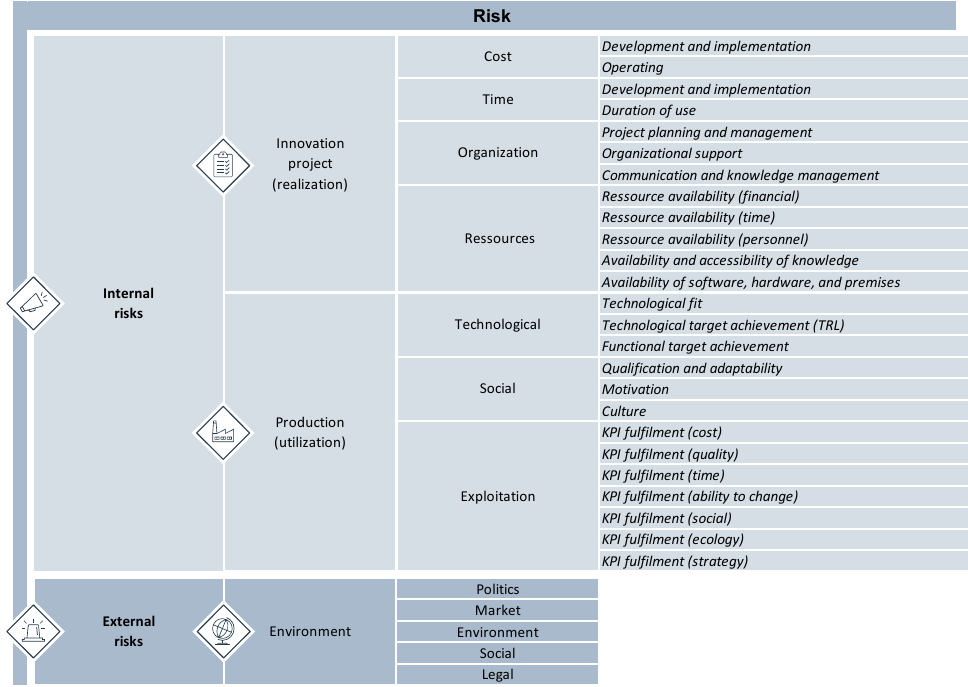
Figure 5. Relevant criteria to assess the efforts of innovation projects in manufacturing.